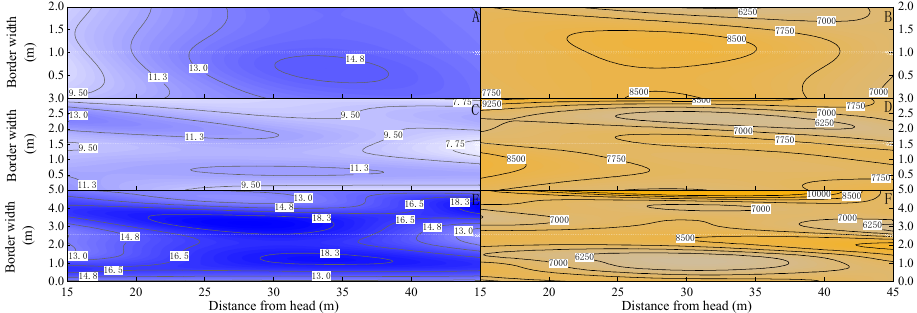
Figure 4. Distribution of soil moisture content ( A , C , and E ) and grain yield ( B , D , and F ) at different positions from the borders with 75 mm irrigation quota.